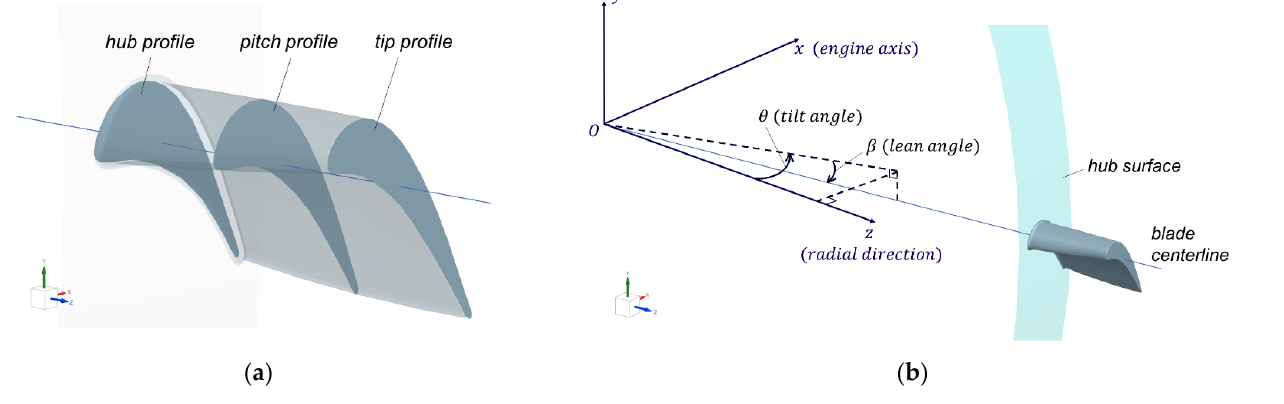
Figure 5. Blade geometry schematics: ( a ) blade geometry adapted from E3 profile coordinates; ( b ) blade angles schematic.